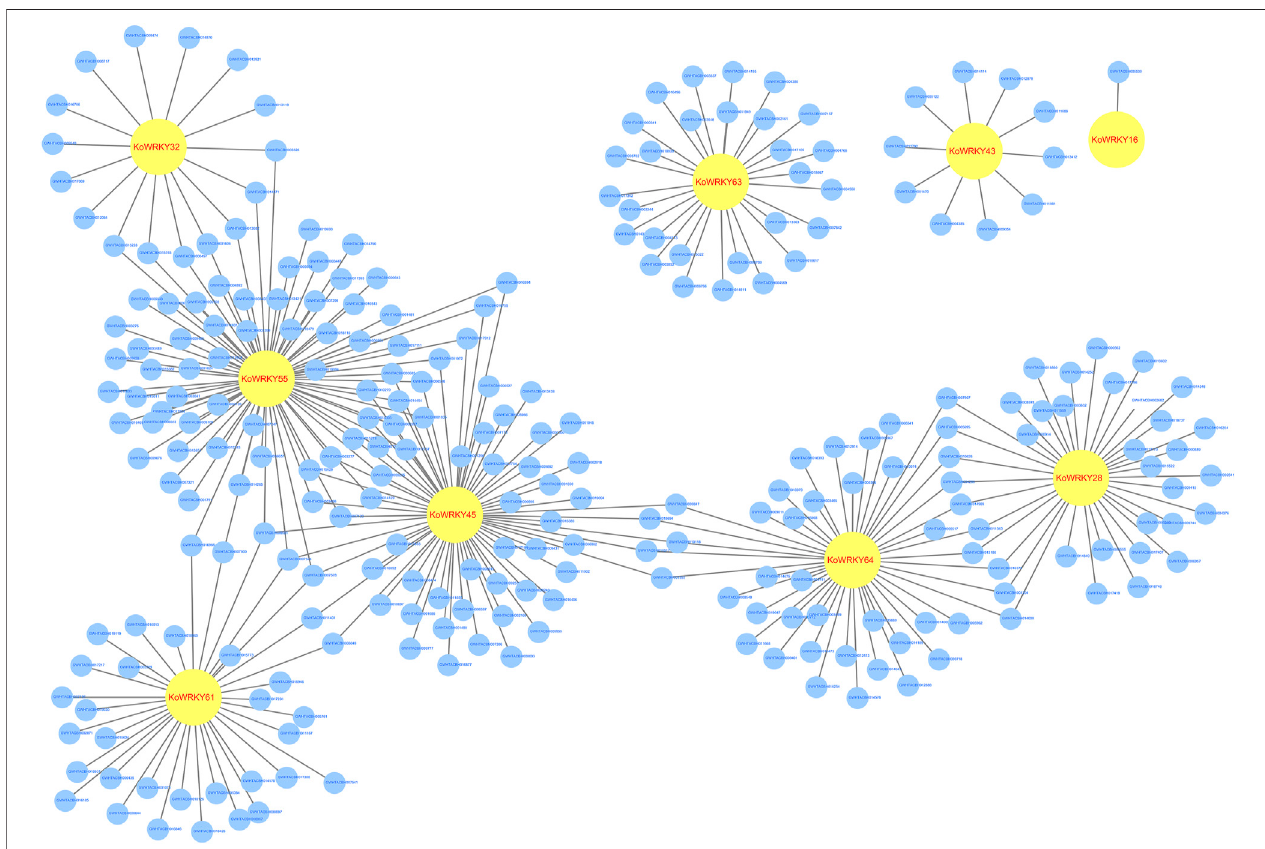
FIGURE 9 | Coexpression network of KoWRKY genes with other genes in Kandelia obovata under cold stress. The coexpression network was established betweenthe9 KoWRKYs and263signi fi cantlyexpressed mRNAswhoseSpearmancorrelationcoef fi cientswereequaltoorgreaterthan0.95.Withinthiscoexpression network, all 315 pairs were positive. The yellow circles represent KoWRKY genes, while the blue circles represent the coexpressed genes.